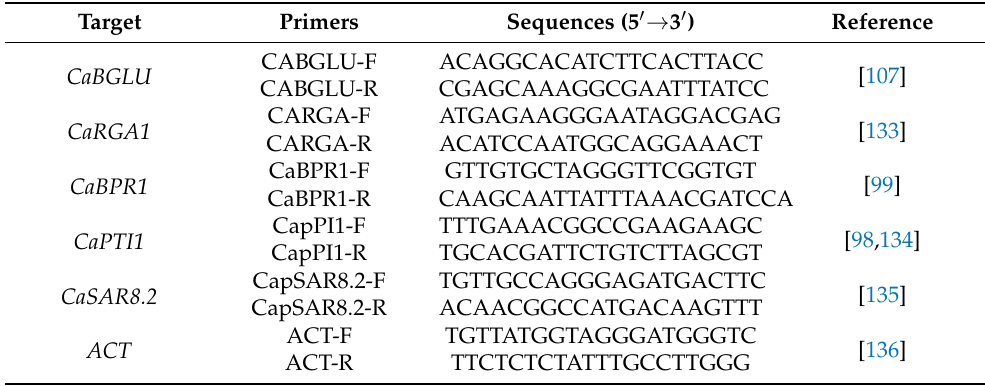
Table 1. PCR primers used in SYBR Green assays.